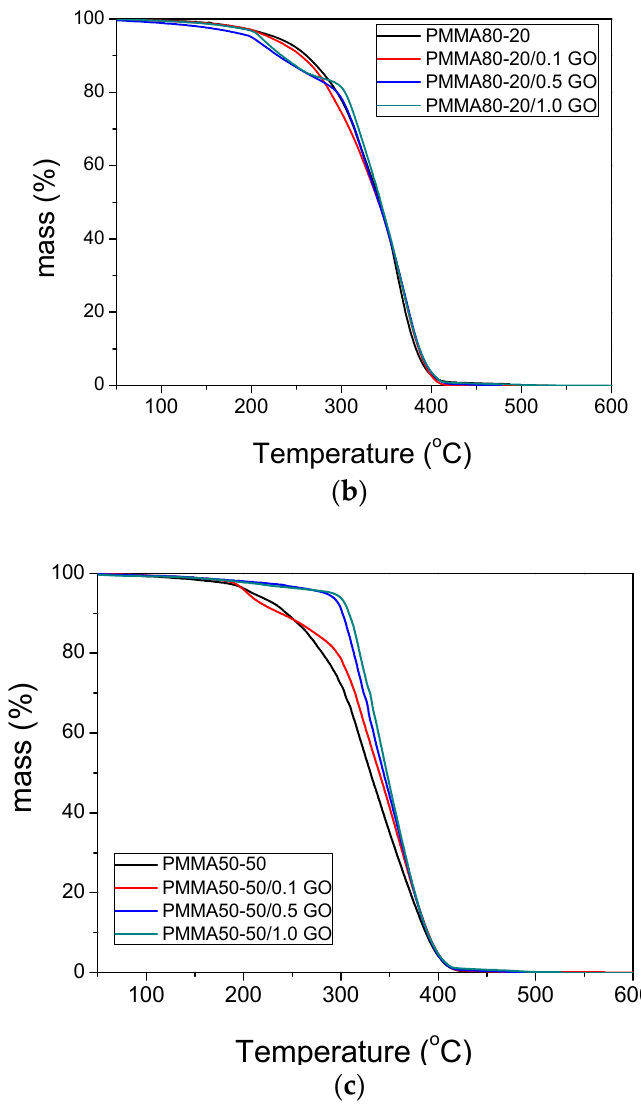
Figure 9. Mass loss of neat PMMA and PMMA/GO nanocomposites with various amounts of added GO obtained in bulk ( a ); solution with 80–20 ( b ); 50–50 ( c ) ratio of monomer to solvent.